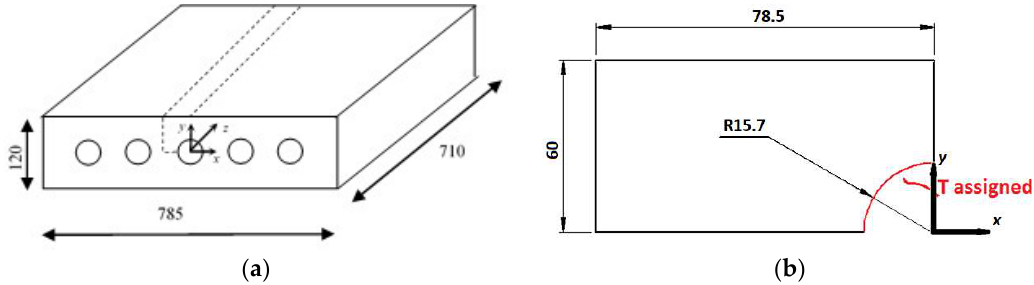
Figure 1. Physical model of TES system. The dotted lines ( a ) represent the computational domain, frontal view of the computational domain ( b ).